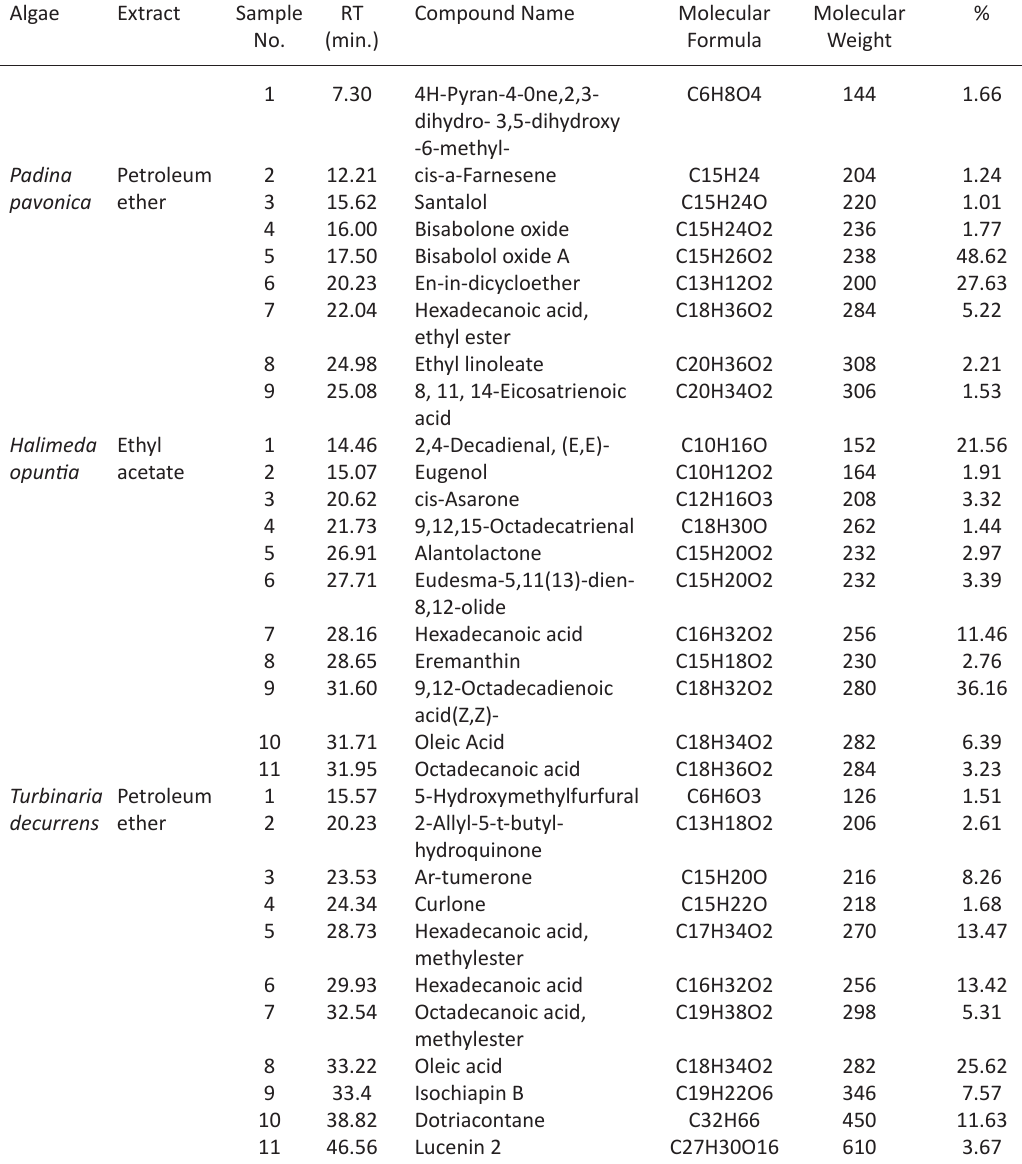
Table 5. Major bioactive chemical constituents identified in the algal extracts according to the gas chromatography- mass spectrometry (GC-MS) chromatogram analysis Algae Extract Sample